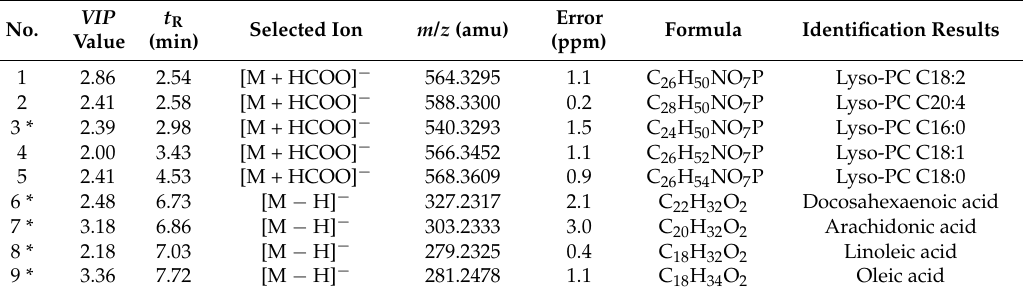
Table 3. The identified candidate markers picked out by the PLS-DA loadings plot.